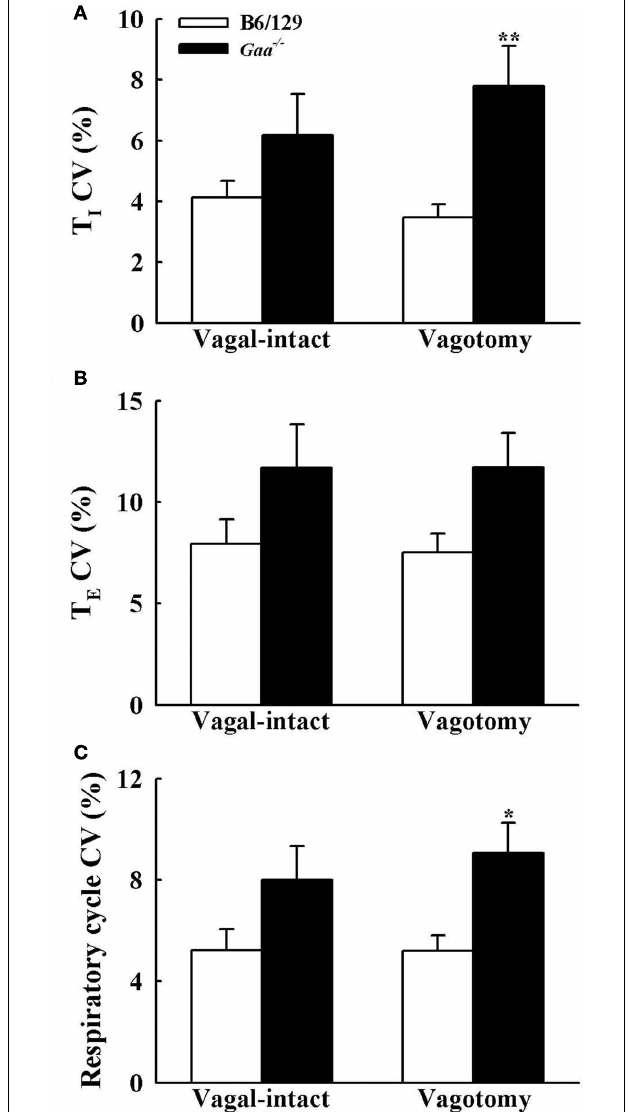
FIGURE 5 |The coefficient of variation (CV) of inspiratory [ T I , (A)], expiratory [ T E , (B)], and total respiratory cycle [ T TOT , (C)] duration during vagal-intact and vagotomized conditions. CV of T I and T TOT is significantly higher in vagotomized Gaa − / − mice than B6/129 mice. * p < 0.05; ** p < 0.01 significant different from B6/129 mice. # p < 0.05 compared with the value during vagal-intact condition.